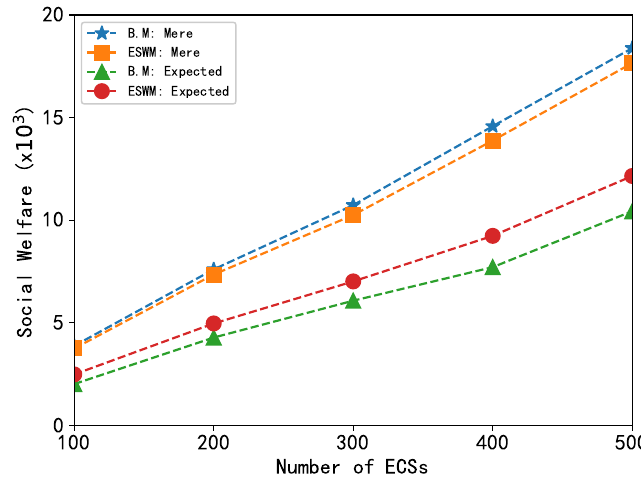
Figure 6. Comparison of expected social welfare under different incentive mechanisms.